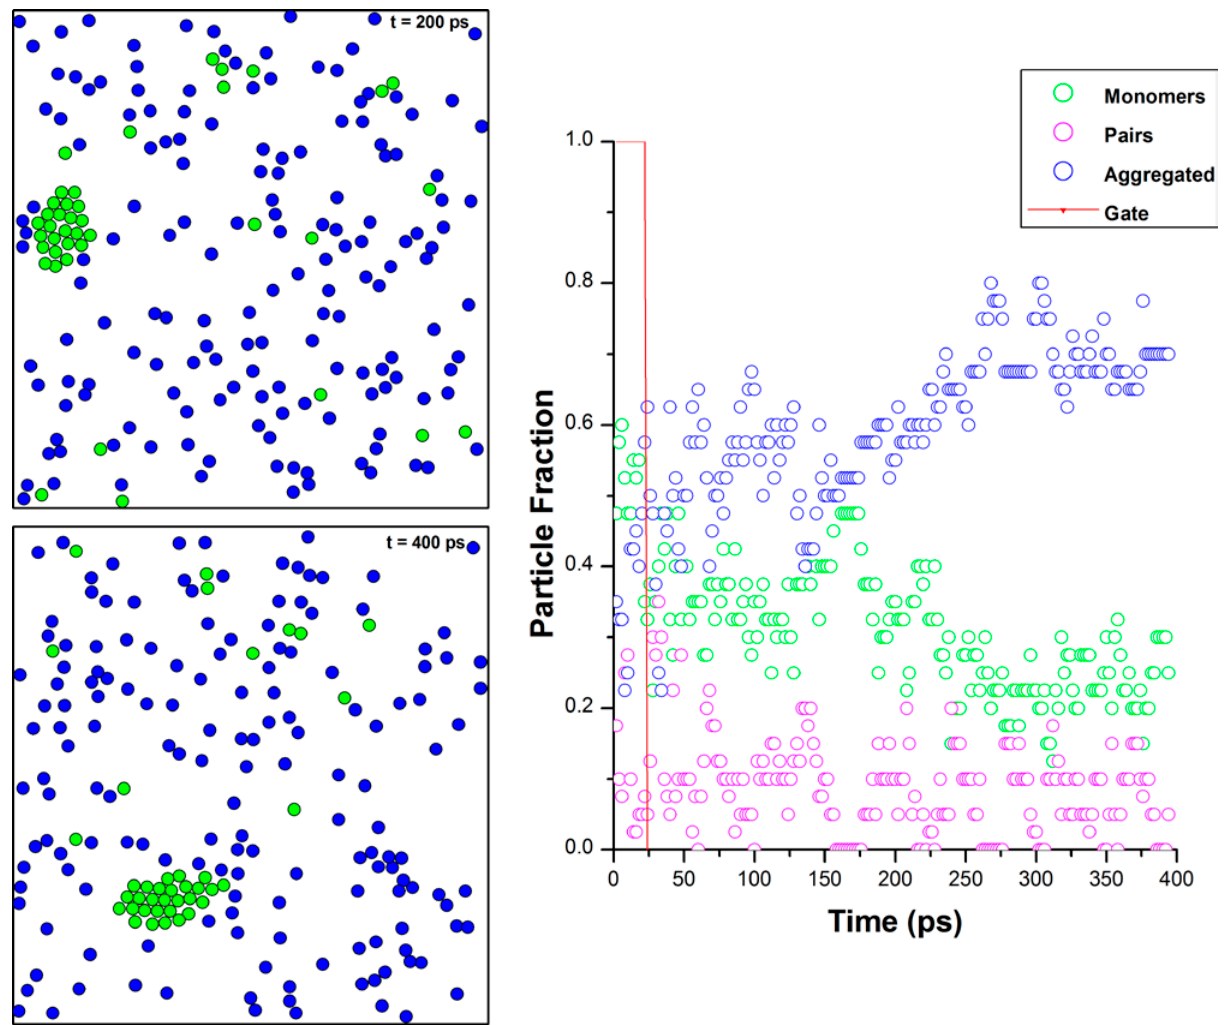
Figure 5. Left: snapshots of the configurations obtained after 200 ps (top) and after 400 ps (bottom) of a simulation for the mixture described in Figure 3 at T = 300 K. The interaction parameters (eV) were: ɛ A-A = 0.01, ɛ B-B = 0.1 and ɛ A-B = 0.05. Right: time evolution of the fraction of B monomers, pairs of B atoms and total aggregated B atoms present in clusters of more than 2 B atoms for the same simulation. The time at which the red line sharply drops to zero indicates when the gate shown in Figure 3 was opened and the particles were allowed to mix. The MD time step was 1